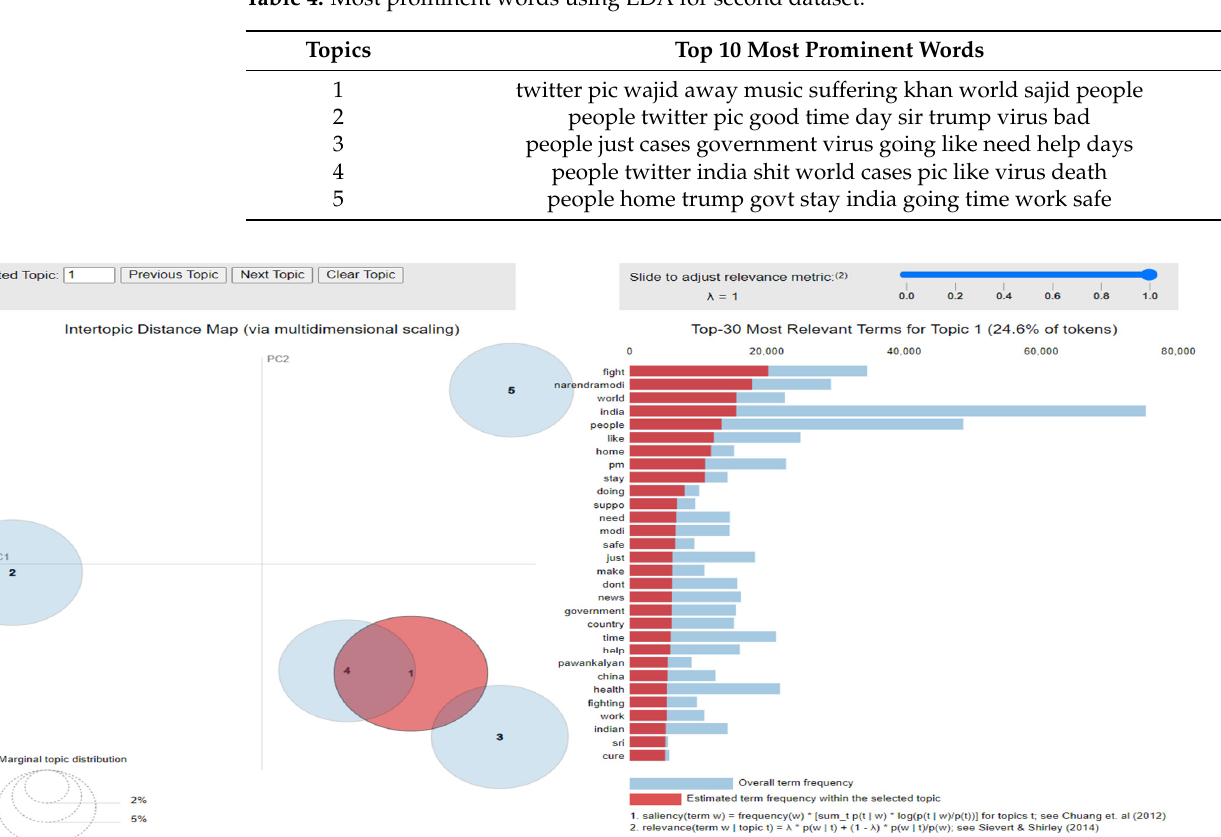
Table 4. Most prominent words using LDA for second dataset.